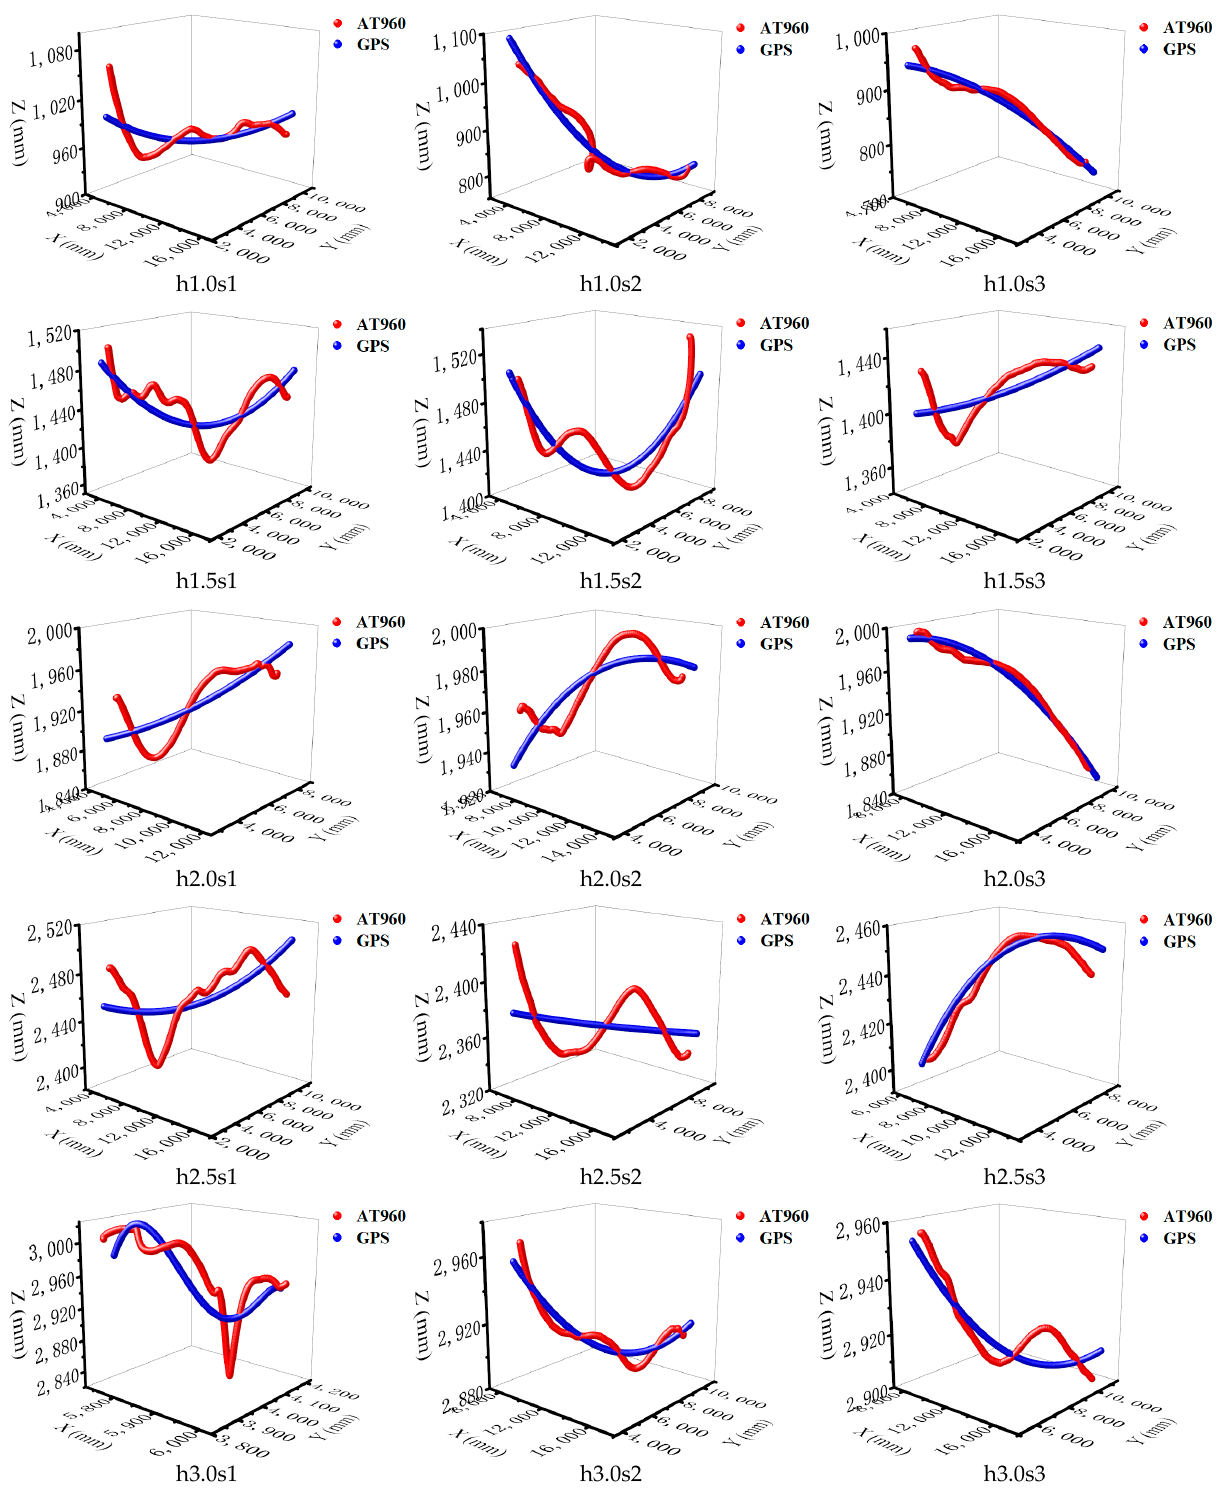
Figure 7. Flight trajectory.